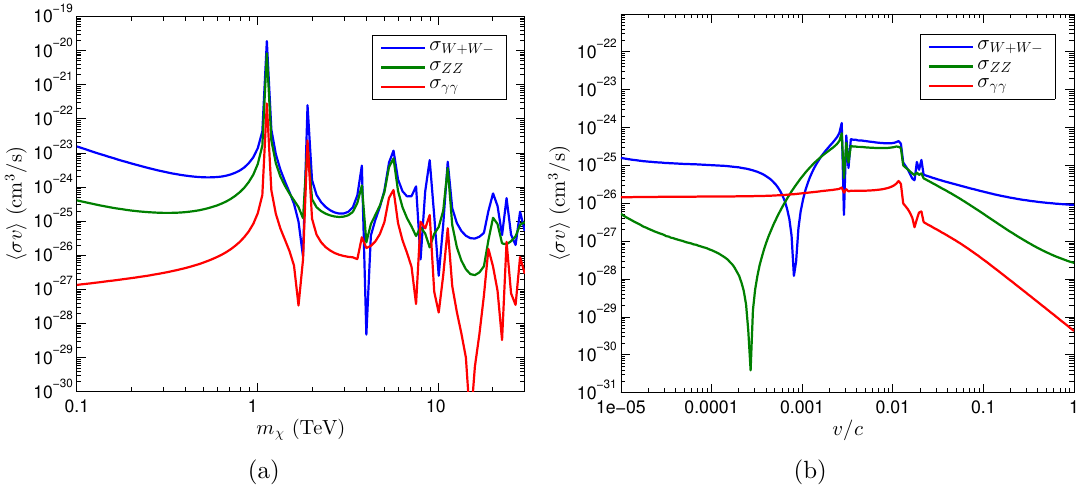
Figure 4. Pseudo-real quartet annihilation cross section into W + W − (blue), ZZ (green) and γγ (red) gauge vectors. In left panel (4(a)) as a function of DM mass at velocity v = 10 − 3 c ; and in right panel (4(b)) as a function velocity at freeze-out mass m 0 = 4 . 05